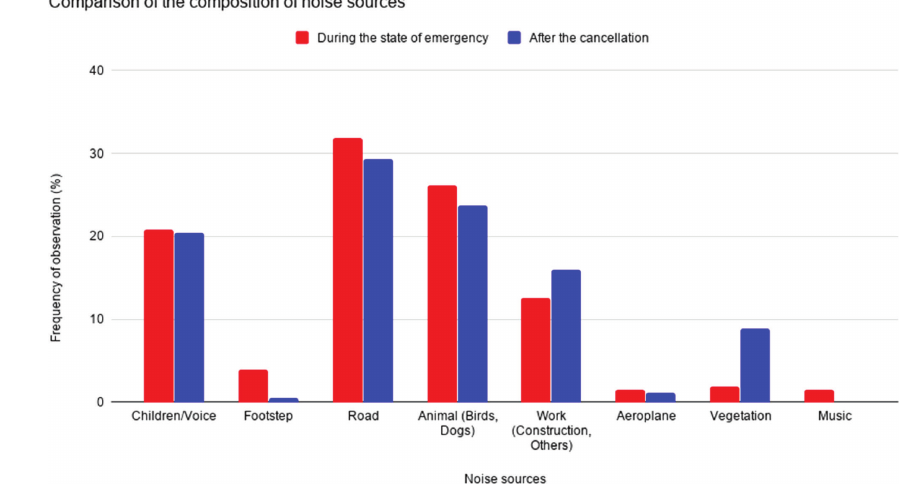
Comparison of the compositions for noise sources of weekdays and weekends (Figs 5 and 6). Note that the percentage of observation of music after the cancellation of the state of emergency was